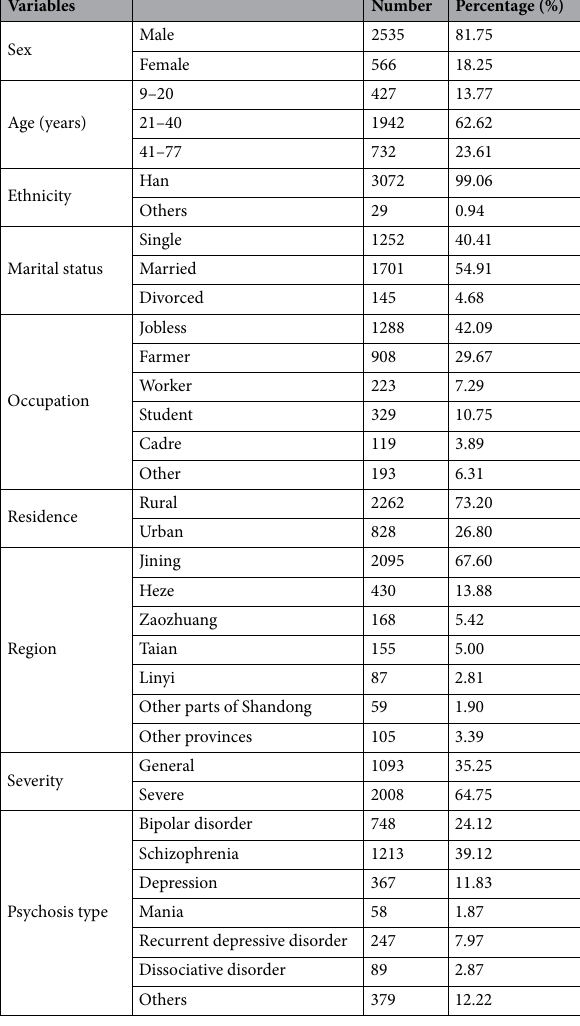
Table 1. Demographic characteristics of the psychiatric patients ( N= 3101).